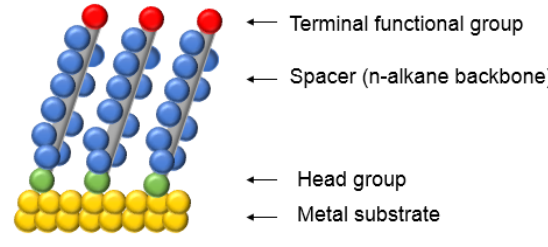
Figure 6: A schematic diagram of SAMs on metal